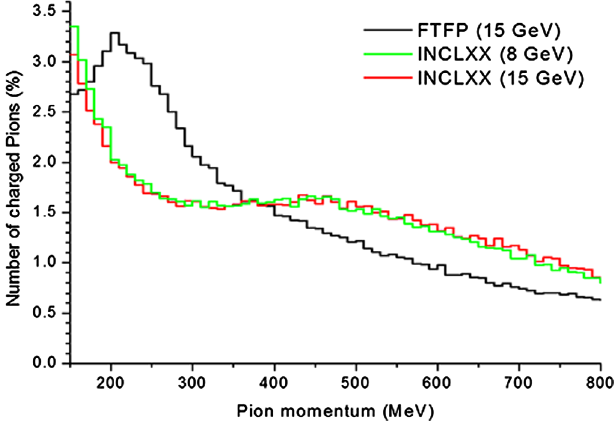
FIG. 12. The momentum distribution of the useful pions produced in the target calculated using INCL and FTF model.